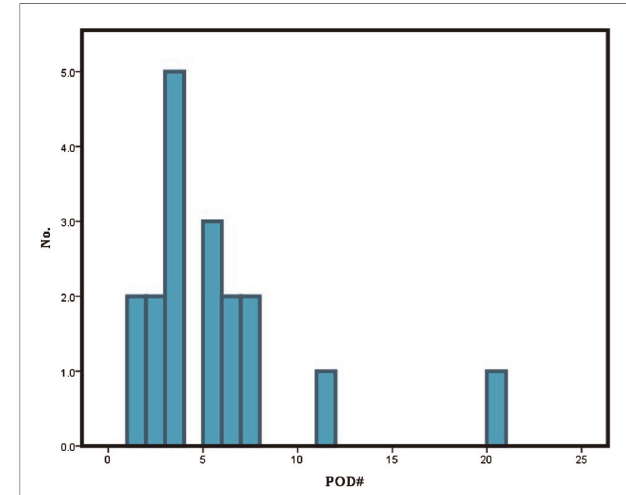
FIGURE 1 | Onset of postoperative delirium in the 18 patients of the delirium